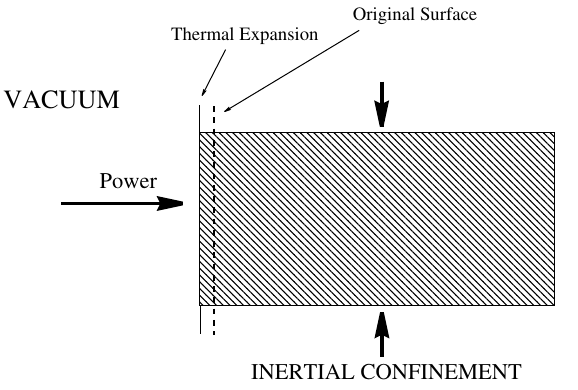
FIG. 2. Metal surface being heated with a fast high-power source [5]. The surface itself expands normally into the vacuum.